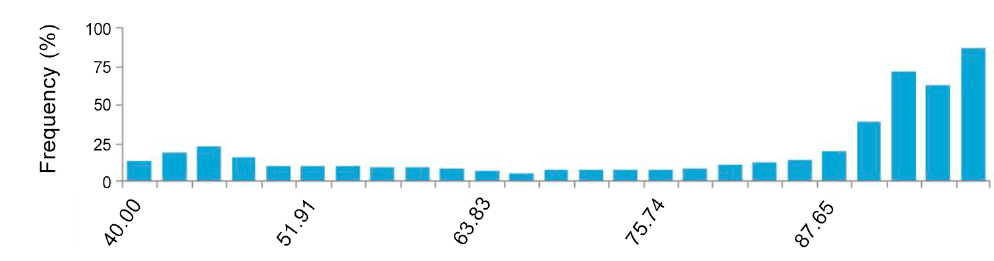
Figure 14. Frequency of SOC throughout the year.